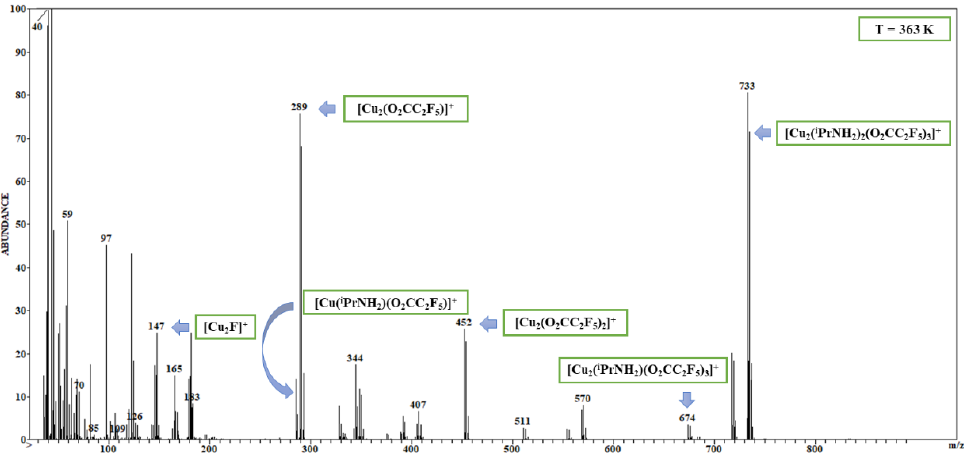
Figure 1. EI MS spectrum of [Cu 2 ( i PrNH 2 ) 2 (µ-O 2 CC 2 F 5 ) 4 ] ( 8 ), T = 363 K.